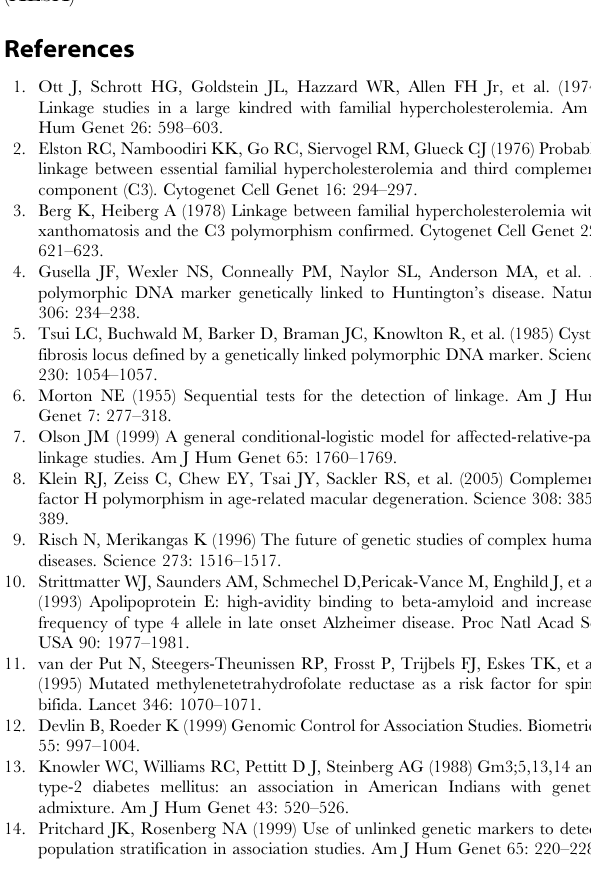
Table S6 Recessive (K = 0.2). Table S7 Codominant (K = 0.01). Table S8 Codominant (K = 0.1). Table S9 Codominant (K =